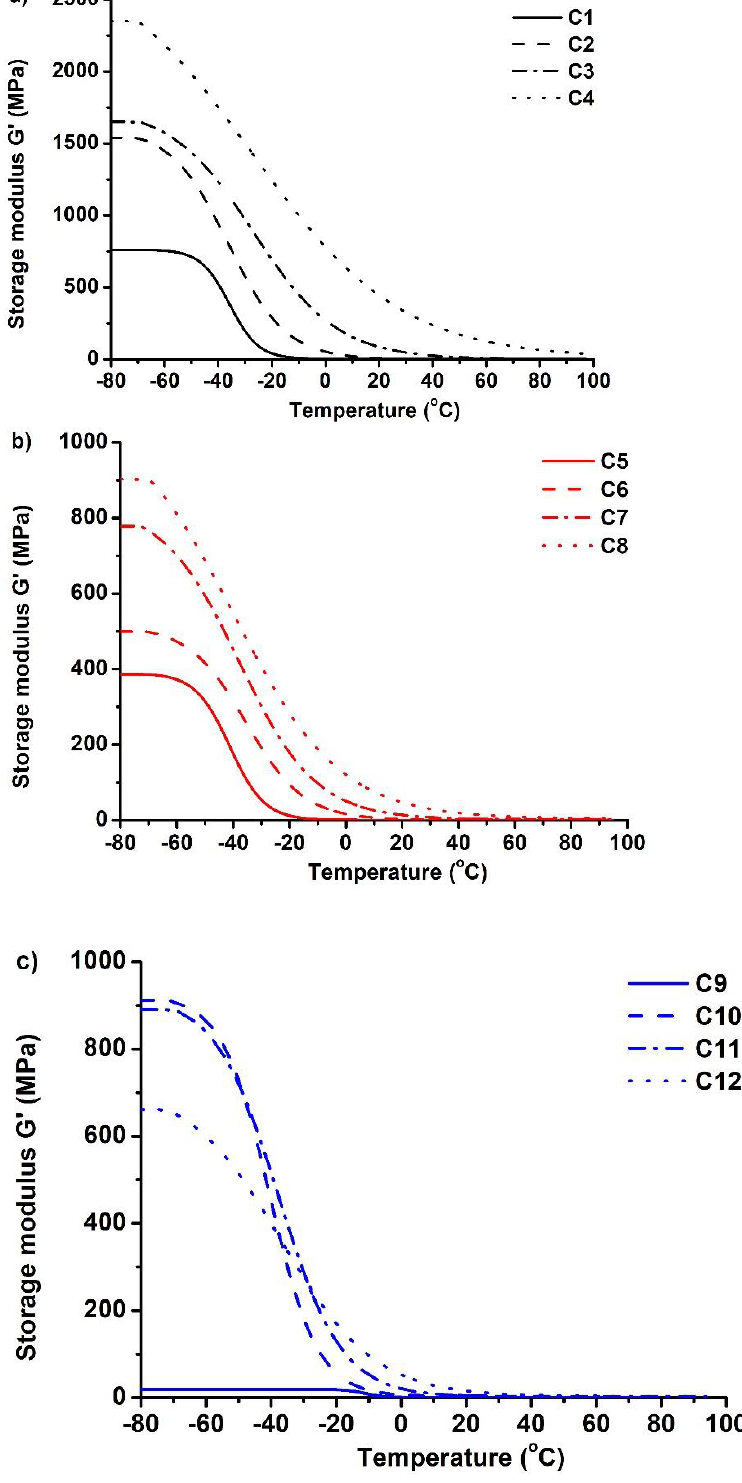
Figure 6. Dependency of the storage modulus G’ of polymers C1 – C4 ( a ), C5 – C8 ( b ), and C9 – C12 ( c ) on temperature.